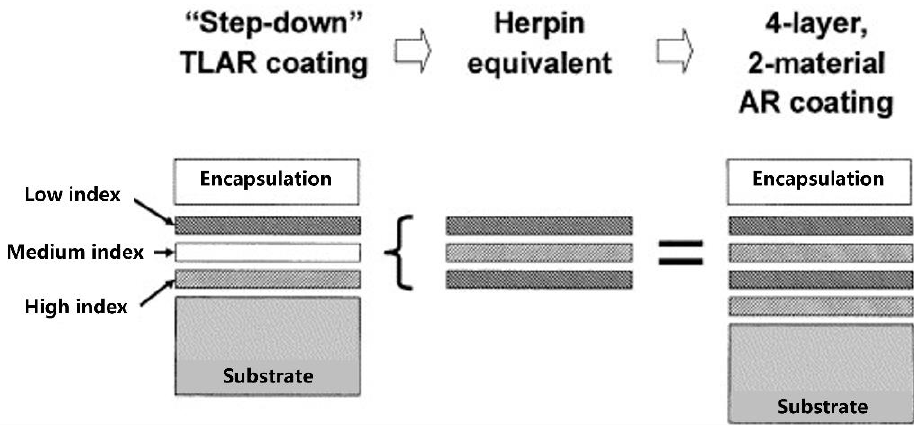
Figure 10. Scheme of the HLHL ARC structure derived from a TLARC structure using the concept of the equivalent layer. Reprinted with permission [13]; 2000, Elsevier.